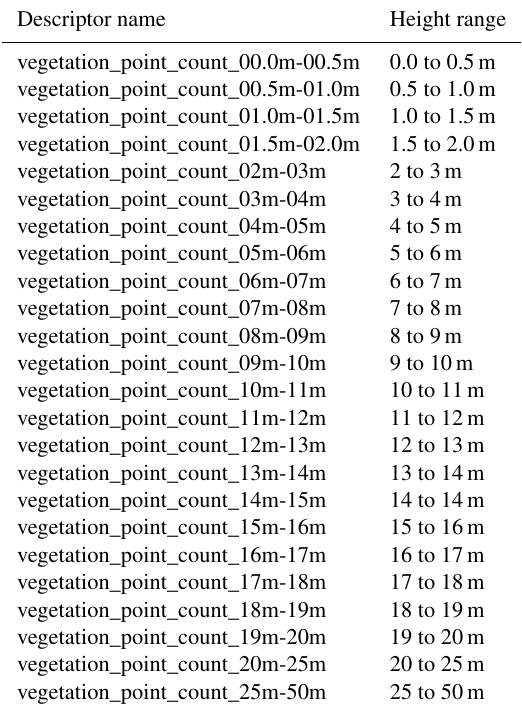
Table 4. Vegetation point-count descriptors divided into 24 height bins. All vegetation point counts include the point classes 3, 4